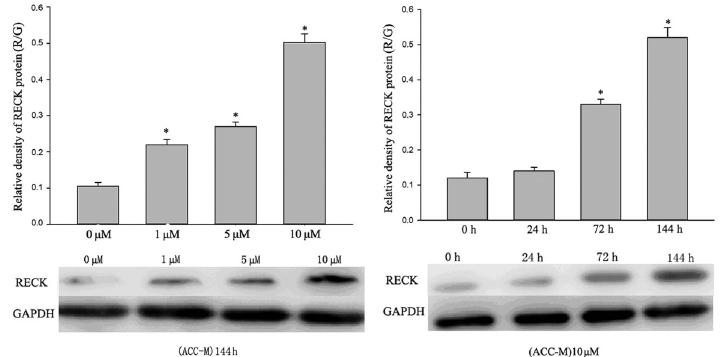
Figure 4. Western blotting results of RECK in ACC-M cells with DMSO or 1, 5, 10 m M 5-aza- 2 9 deoxycytidine (5-aza-dC) treatment for 144 h and treated for 24, 72, and 144 h with 10 m M 5- aza-dC. R/G represents the brightness ratio of the RECK protein (106 kDa) vs GAPDH (36 kDa). *P , 0.05 compared with control